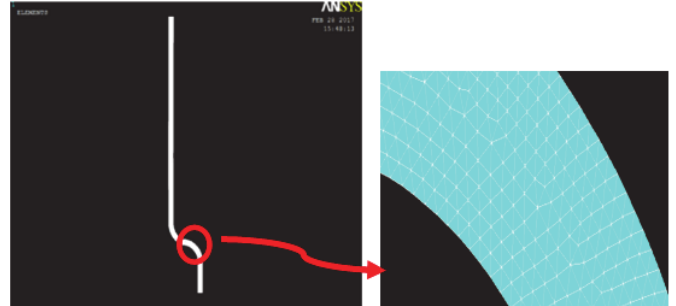
Figure 2: Meshing of the expansion bellows.